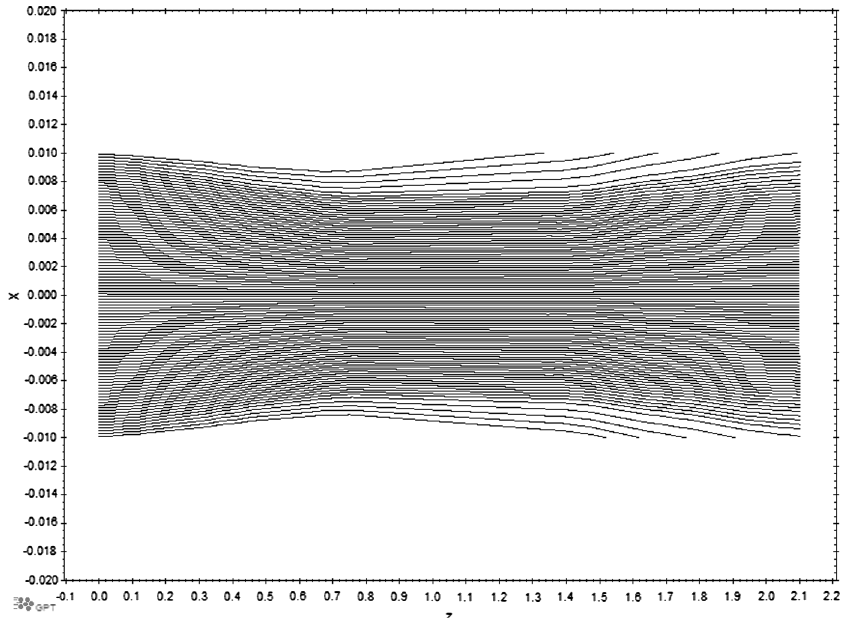
FIG. 10. Trajectory of parallel beam through first focusing